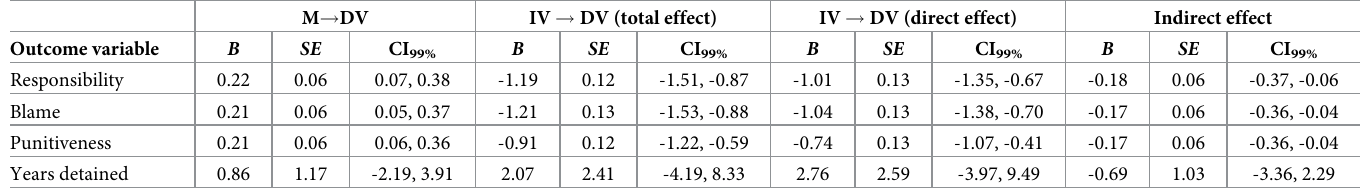
Table 5. Mediation model statistics: Effects of defense of mental impairment on crime judgments via agency (Study 2). M !